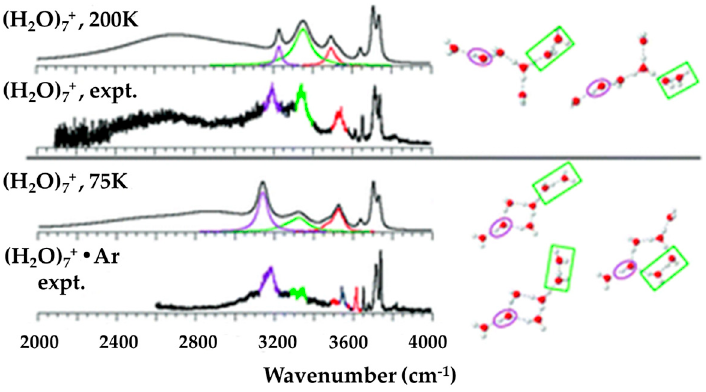
Figure 25. Infrared spectra of neat and Ar-tagged (H 2 O) 7 + • compared with simulated spectra of (H 2 O) 7 + • at 200 K and 75 K [102]. Figure adapted from [102] with permission. Copyright 2014 The Royal Society of Chemistry.